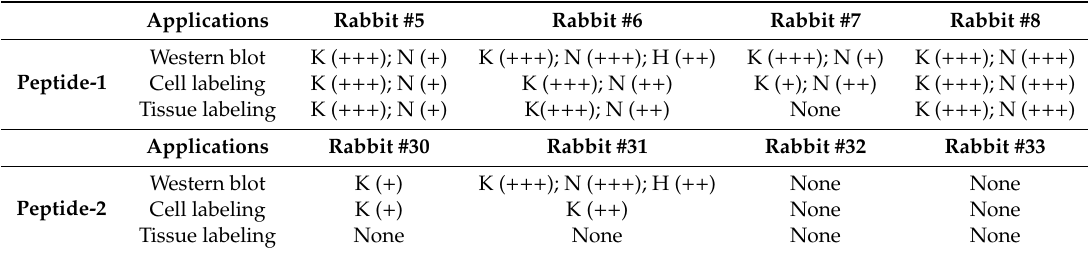
Table 1. Characteristics of the di ff erent sera tested in this study. The level of target recognition is illustrated as follows: +++ : high; ++ : moderate; + : low. K: KRAS, N: NRAS, H: HRAS. #: hashtag precedes the specific number attributed for each